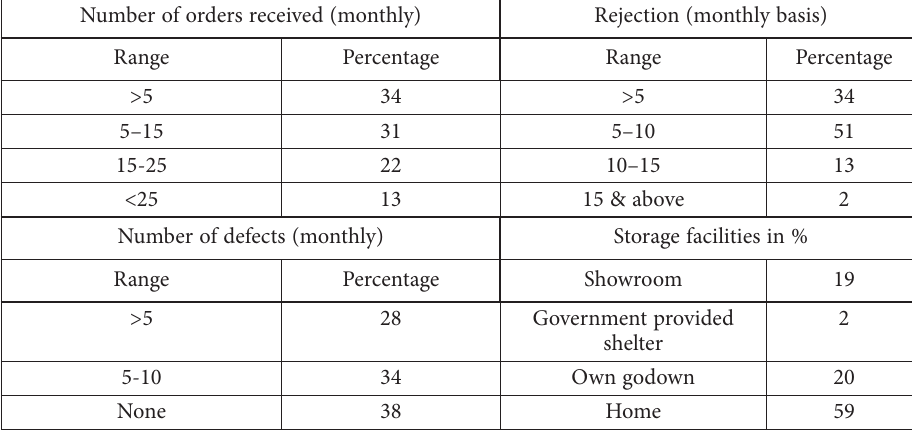
Table 3. Profile of order, rejection, defects and storage facilities (source: created by authors) Number of orders received